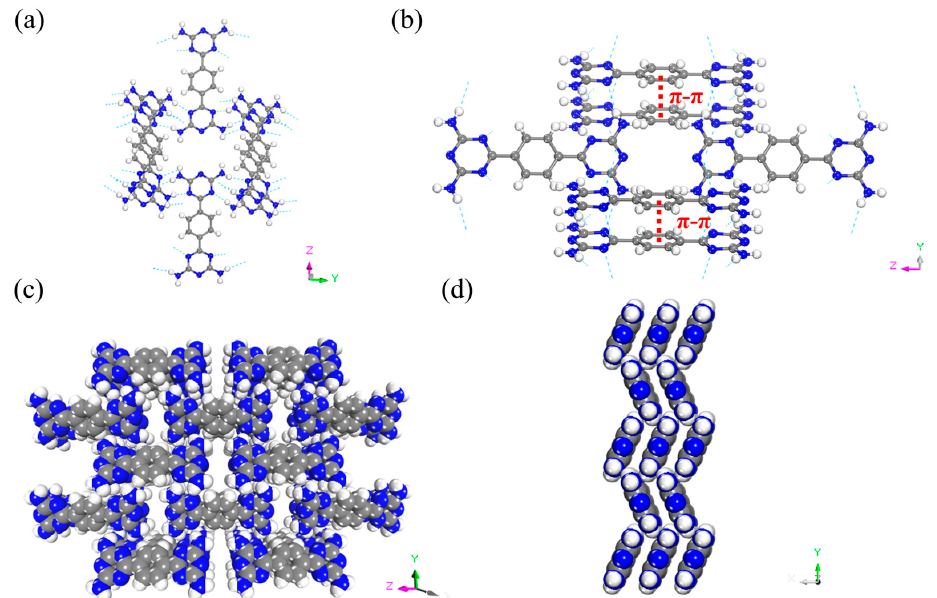
Figure 2. ( a ) Crystal structure of FDU-HOF-1 showing the channels along the x -axis. ( b ) Mi-croporous channel showing the hydrogen bond and the π - π stacking between benzene groups. FDU-HOF-1 host framework along ( c ) x -axis and ( d ) y -axis (green dashed lines present H-bonds , red dashed lines present π - π stacking, N blue, H withe and C grey).